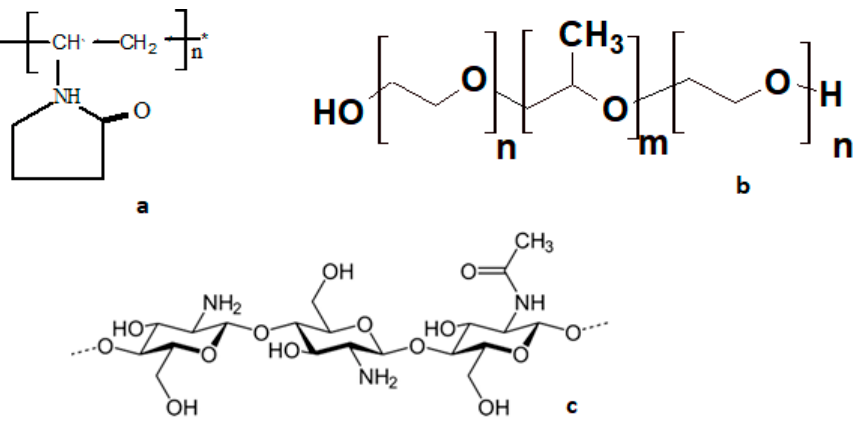
Figure 2. Structural formulas of polymers: poly-N-vinylpyrrolidone ( a ), ternary block copolymer of ethylene and propylene oxide, Pluronic F127, where n = 65; m = 200 ( b ), chitosan ( c ).